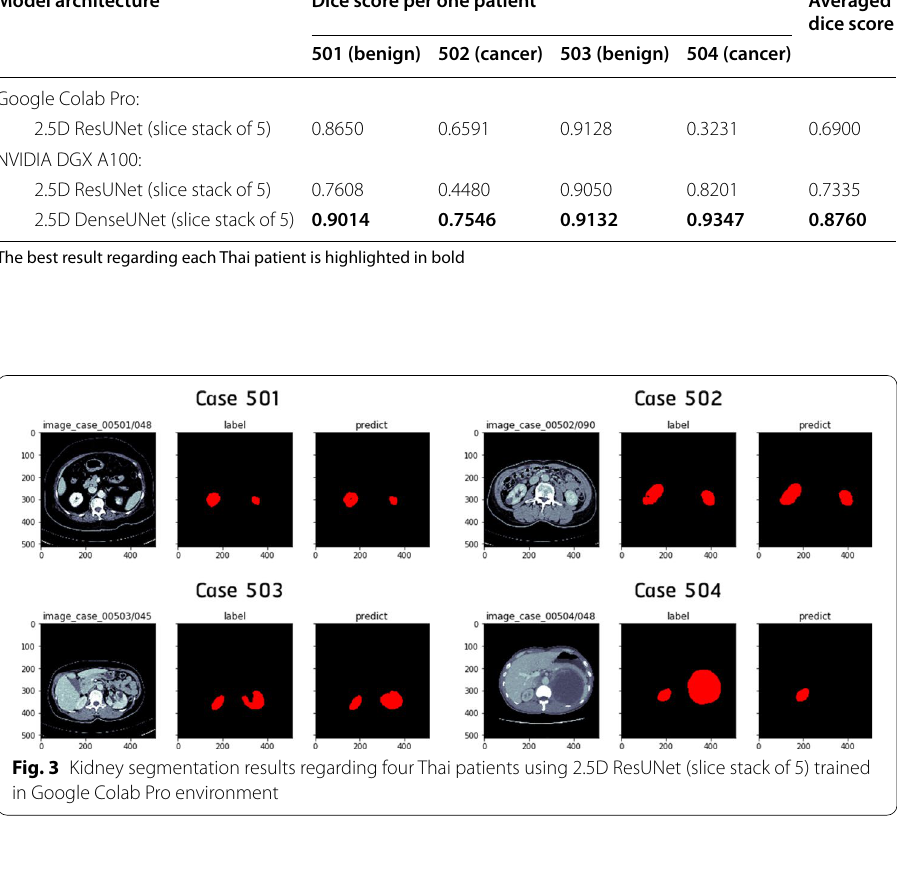
Table 2 Detail experimental results regarding each Thai patient Model architecture